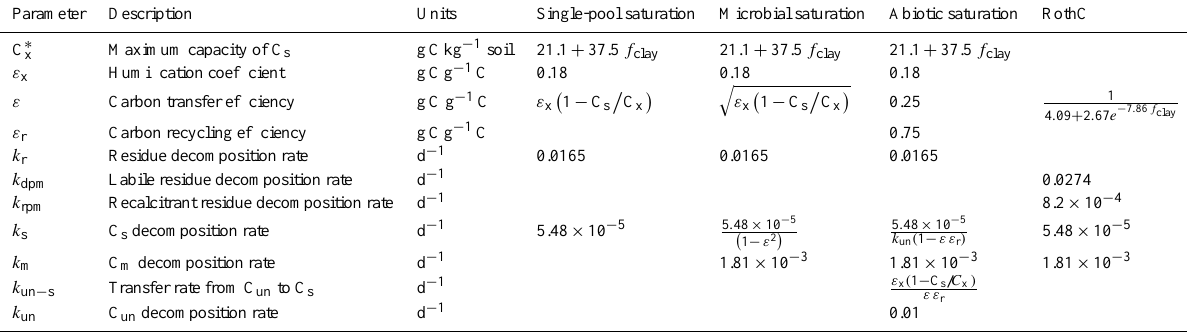
Table 1. The parameter values used in each model.